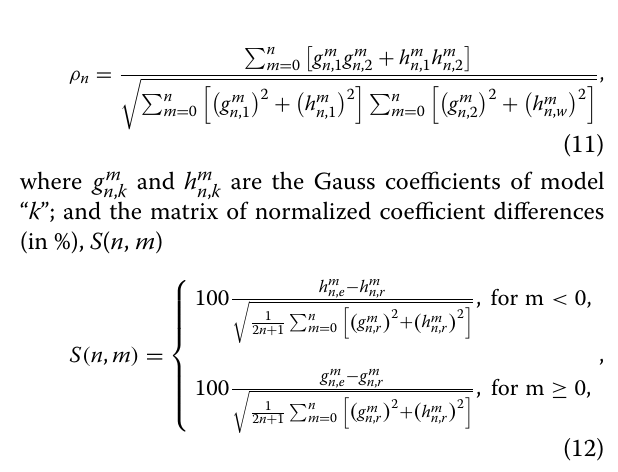
where the subscripted “ e ” and “ r ” indicate the Gauss coefficients of the evaluated and reference models, respectively. The top-left plot of Fig. 5 shows the R n spectra for CM6, LCS1, and CIY4 and the differences between CM6 and the other two models for SH degrees n 6,371.2 km . According to this metric, the at radius a = CM6 lithosphere is in better agreement with CIY4 up to